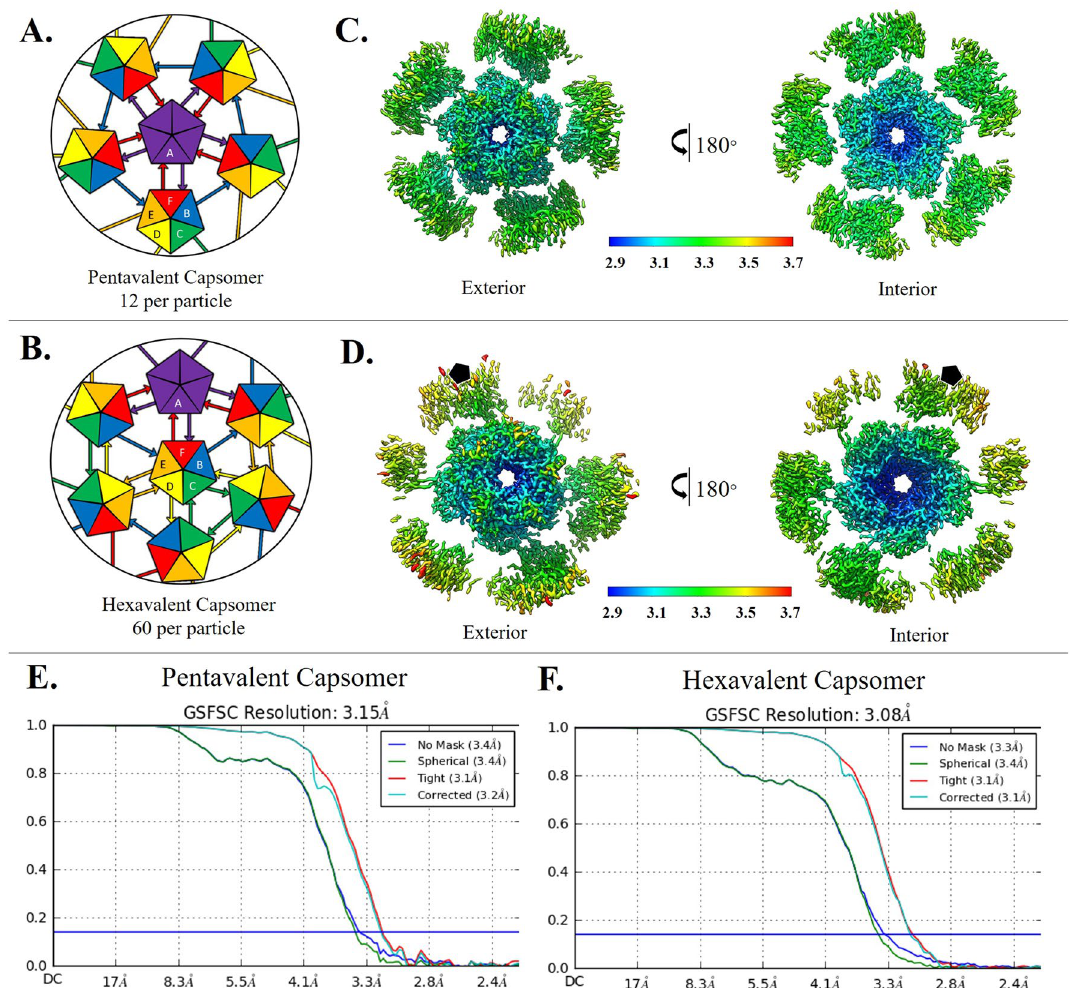
Figure 1. Capsomer environments and subparticle refinement. ( A , B ) Illustrated graphically by cartoons of pentavalent and hexavalent capsomers, the HPV capsid asymmetric unit is made up of six L1 chains, labeled chain A–F and colored purple, blue, green, yellow, orange, and red respectively. ( A ) Each A chain of the pentavalent capsomer makes a connection with chain F of the neighboring hexavalent capsomer, showing fivefold icosahedral symmetry. The pentavalent capsomer is surrounded by single arm connections of chain B to chain E of hexavalent capsomers in a counterclockwise ring contribution. ( B ) Each C chain (green) can be seen interacting with another C chain, showing threefold icosahedral symmetry. Each E chain (orange) contributes to D chain (yellow), showing twofold symmetry. ( C , D ) Surface rendered subvolumes colored according to local resolution (color key) with exterior views (upper panels) and views flipped 180° for interior view (lower panel). Highest resolution (blue) in both environments is seen at the interior core of the capsomer with resolution diminishing at the connecting arms and at the outer edges ( C ) Pentavalent subvolumes are centered on the fivefold icosahedral symmetry axes, whereas a black pentagon identifies the fivefold axis location in the hexavalent capsomer ( D ). ( E ) Pentavalent capsomer FSC curve to 3.15 Å. ( F ) Hexavalent capsomer FSC curve to 3.08